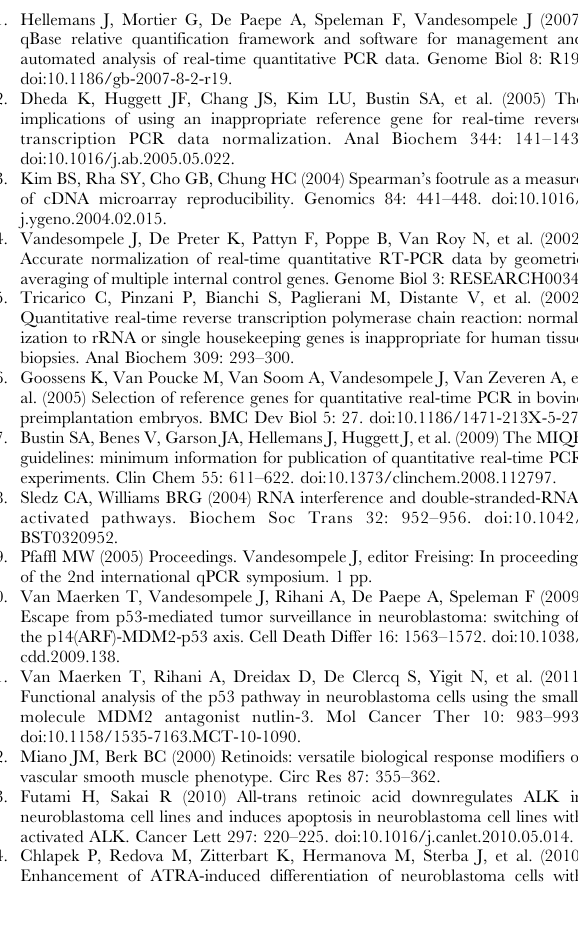
(TIF) Table S1 Chemical inhibitors. A list of the 90 chemical inhibitors and the genes they target. (XLSX) File S1 Experimental design and manipulation of the cell lines. Transient transfections of SH-EP cells with siRNAs against transcribed ultraconserved regions, and optimization of concentration of PHF- 6 -targetting siRNAs in T-ALL cell lines. File S2 Cell lines and culturing of cells . Information about the source and the culturing conditions of the cell